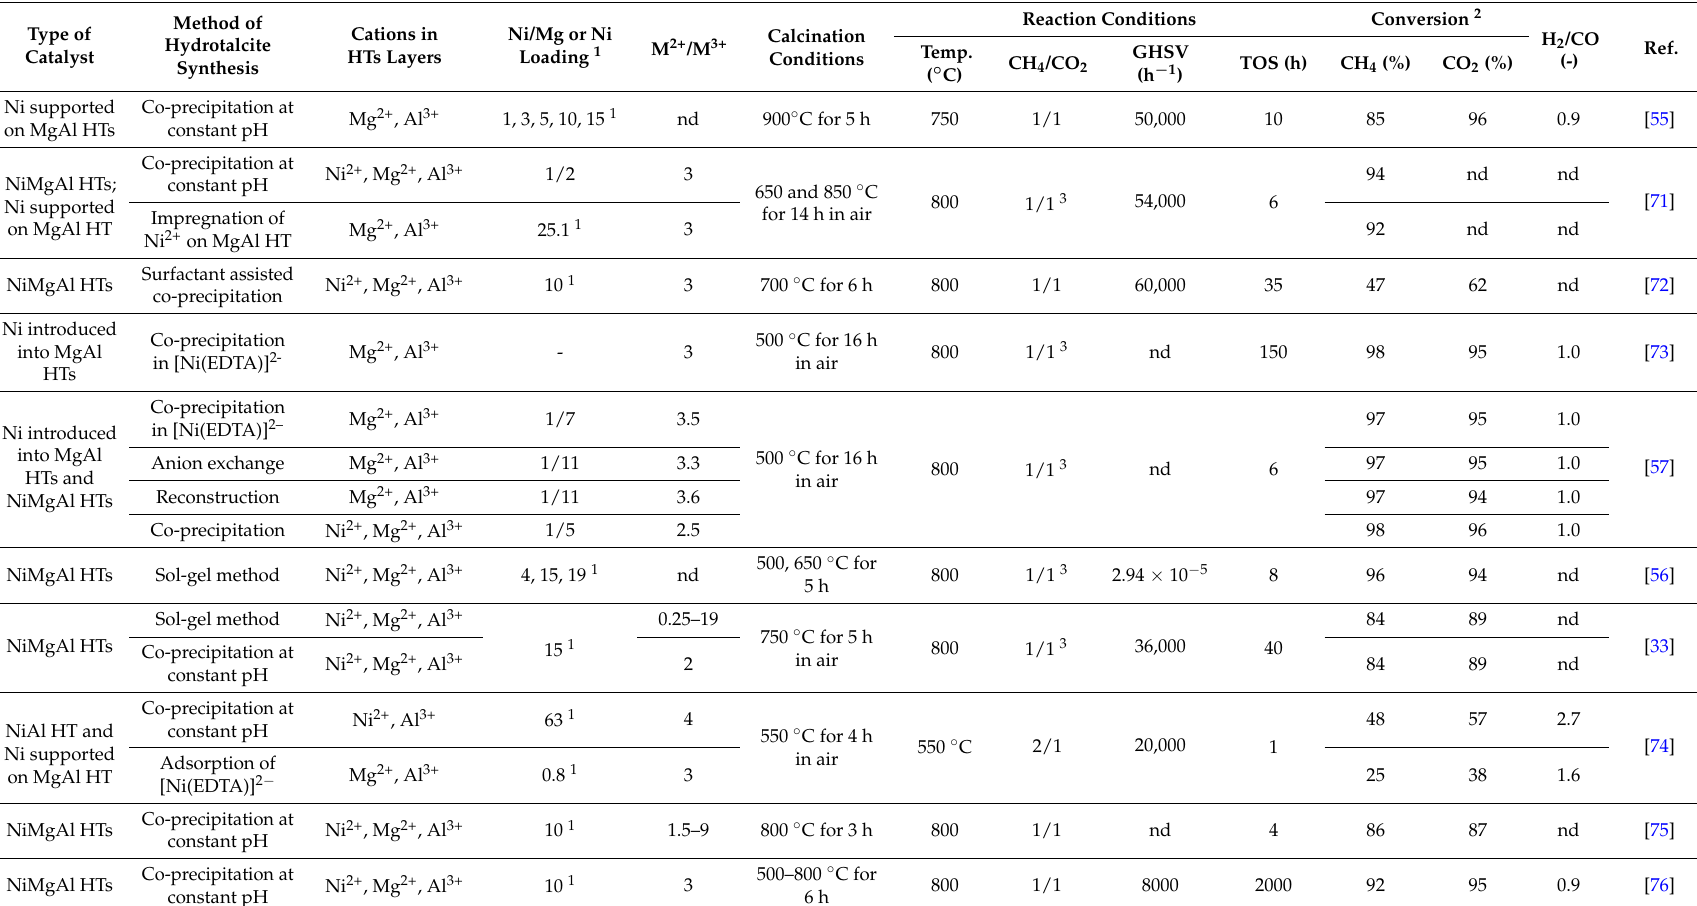
Table 2. The summary of Ni/Mg/Al hydrotalcite-derived catalysts into which nickel was incorporated via various